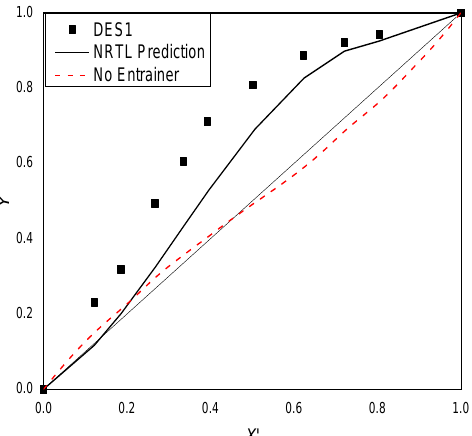
Figure 6. Experimental and calculated data X’Y diagram for cyclohexane (1) + benzene (2) + DES(1:2) (3) at constant pressure (101.325 kPa) and constant DES molar fraction ( X 3 = 0.1).